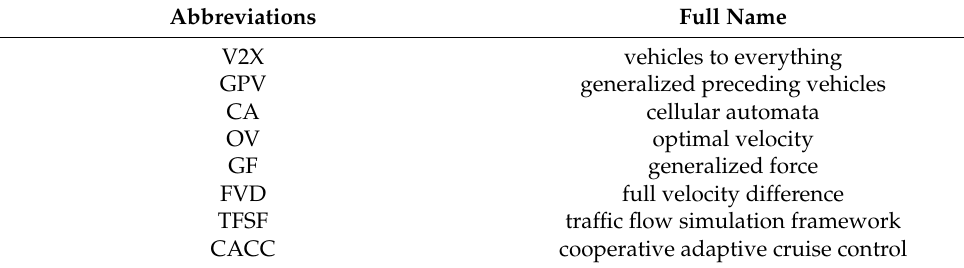
Table A1. All abbreviations and the corresponding full